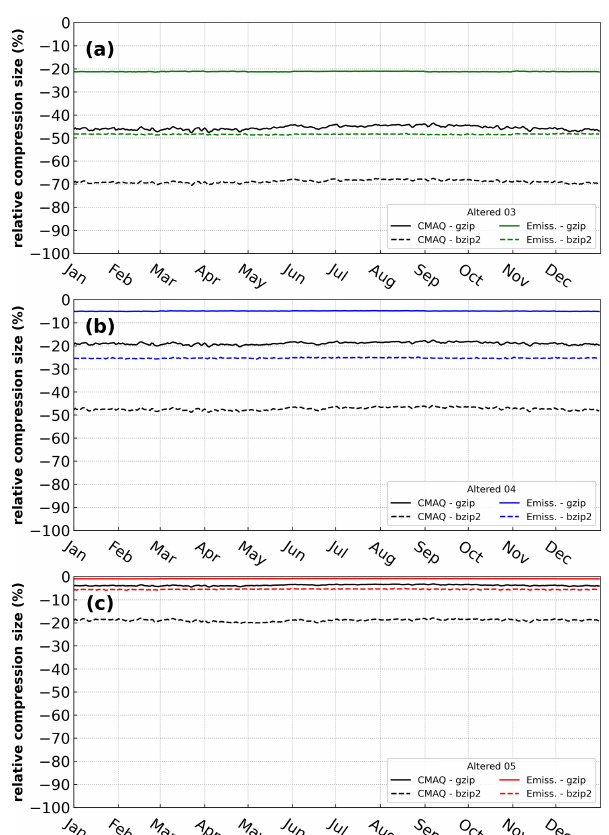
Figure 2. Relative compression size of two utilities, gzip (solid line) and bzip2 (dotted line), on daily emission files (labeled as Emiss.) and direct CMAQ output (labeled as CMAQ) for 2016 with reduced precision settings: 5, 4, and 3 (labeled as Altered 05, Altered 04, and Altered 03, respectively). Negative values indicate better com- pression